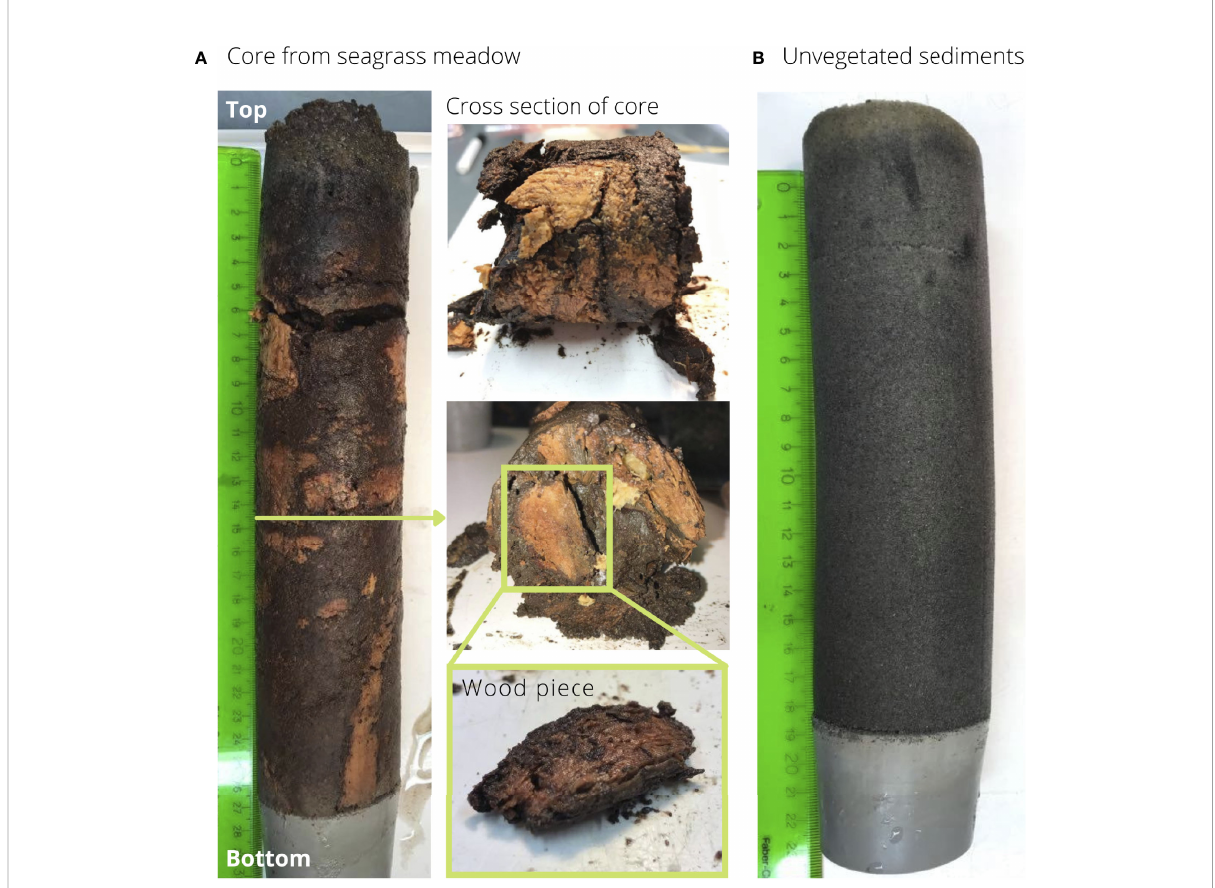
FIGURE 2 Sediment cores from Zostera marina seagrass-vegetated (A) and adjacent unvegetated (B) sublocations in Sierksdorf, Luebeck Bay, where unexpectedly large amounts of exceptionally well-preserved wood pieces were